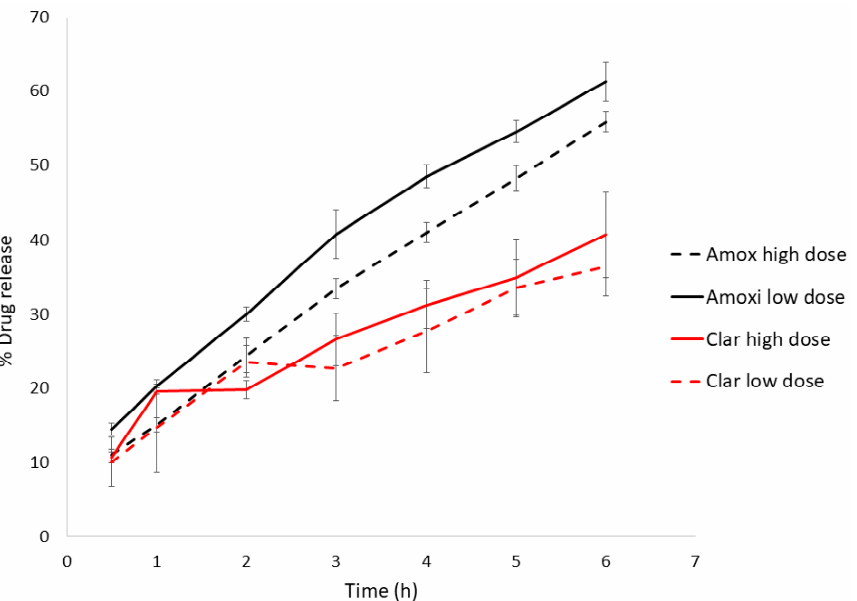
Figure 1. Highest and lowest dose dissolution profiles of Amox and Clar in Mucolast ® . High dose: 89.4 mg/kg/day of Amox and 44.7 mg/kg/day of Clar. Low dose: 8.94 mg/kg/day of Amox and 4.47 mg/kg/day of